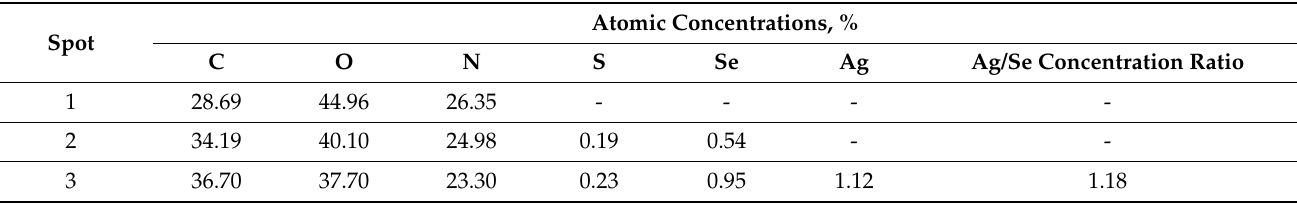
Table 2. Fractional thickness of Ag–Se film layers on nylon. Table 3. Chemical composition from each fractional layer (spot 1, spot 2, and spot 3, as marked in Figure 3) of the Ag–Se-6/nylon nanocomposite obtained by